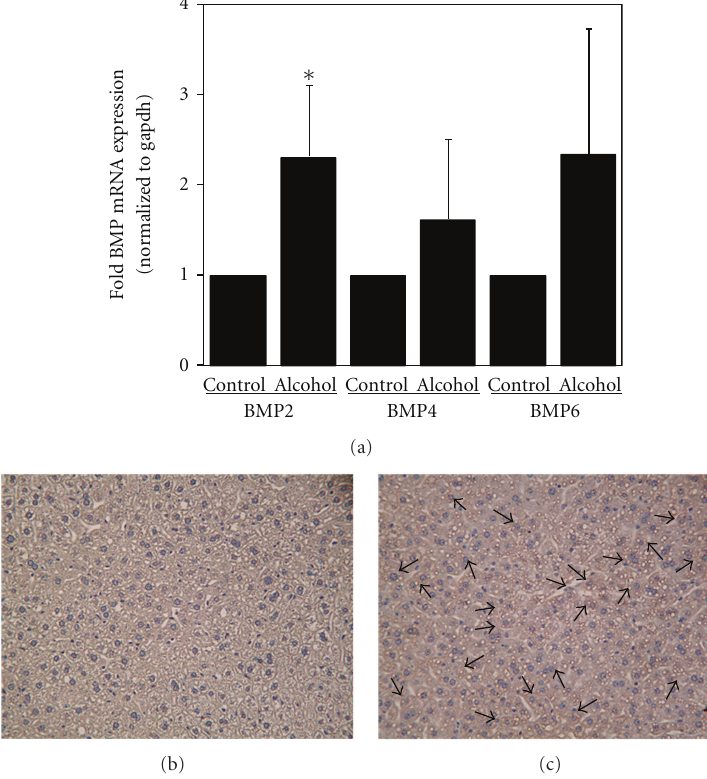
Figure 4: Alcohol and BMP2, BMP4, BMP6 Expression . (a) cDNA was synthesized from liver RNA of mice fed with regular (control) or ethanol-containing (alcohol) Lieber-De Carli liquid diets, as described in Materials and Methods. It was employed in real-time PCR to detect bone morphogenetic protein (BMP) expression. The mRNA expression in alcohol-fed mice was expressed as fold of that in pair-fed control mice fed with regular diet (mean ± S.E.M.; n = 3, 4 mice per group). Asterisks indicate statistical significance ( P < 0 . 05). The fixed liver sections of mice fed with regular (b) or ethanol-containing (c) Lieber-De Carli liquid diets were immunostained with an anti-BMP2 antibody, as described in Materials and Methods. The arrows indicate BMP2 expression (original magnification 20X).